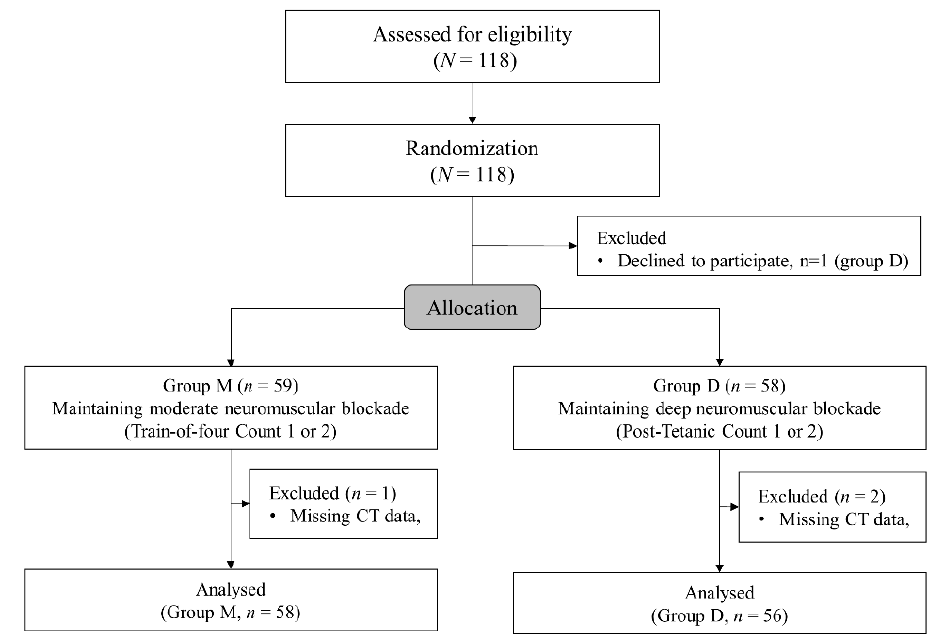
Figure 2. The CONSORT